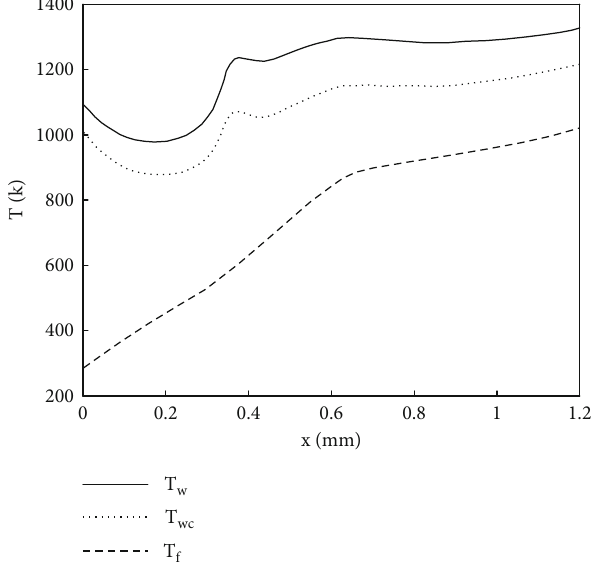
Figure 18: Distributions of wall temperature and fuel temperature.